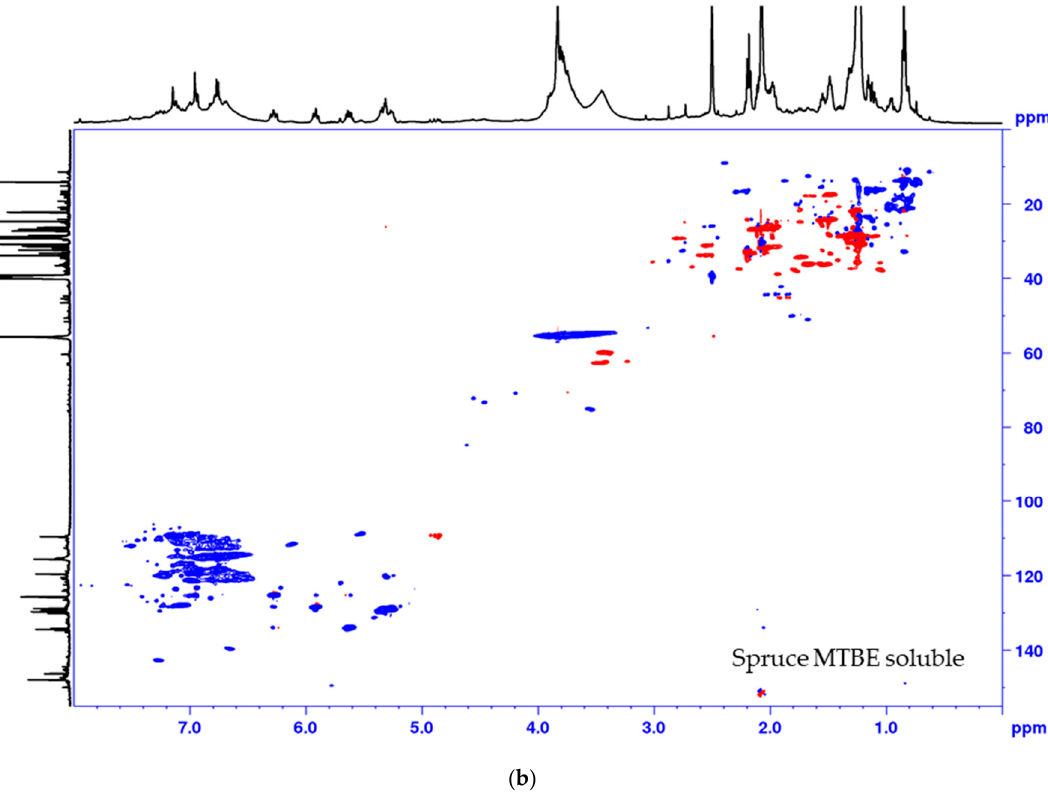
Figure 4. Multiplicity edited HSQC of the MTBE soluble fraction from the process of ( a ) pine and ( b) spruce. CH/CH 3 shown as positive (blue) and CH 2 as negative (red).